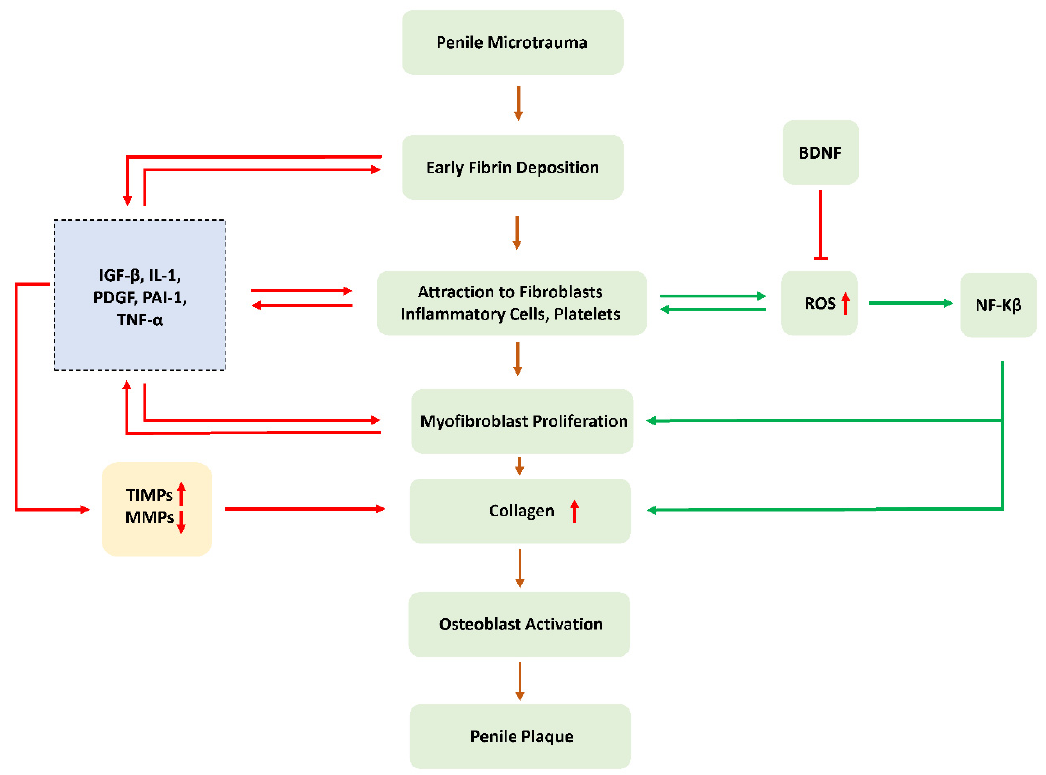
Figure 2. Schematic diagram of the effect of ROS on the progression of fibrosis.